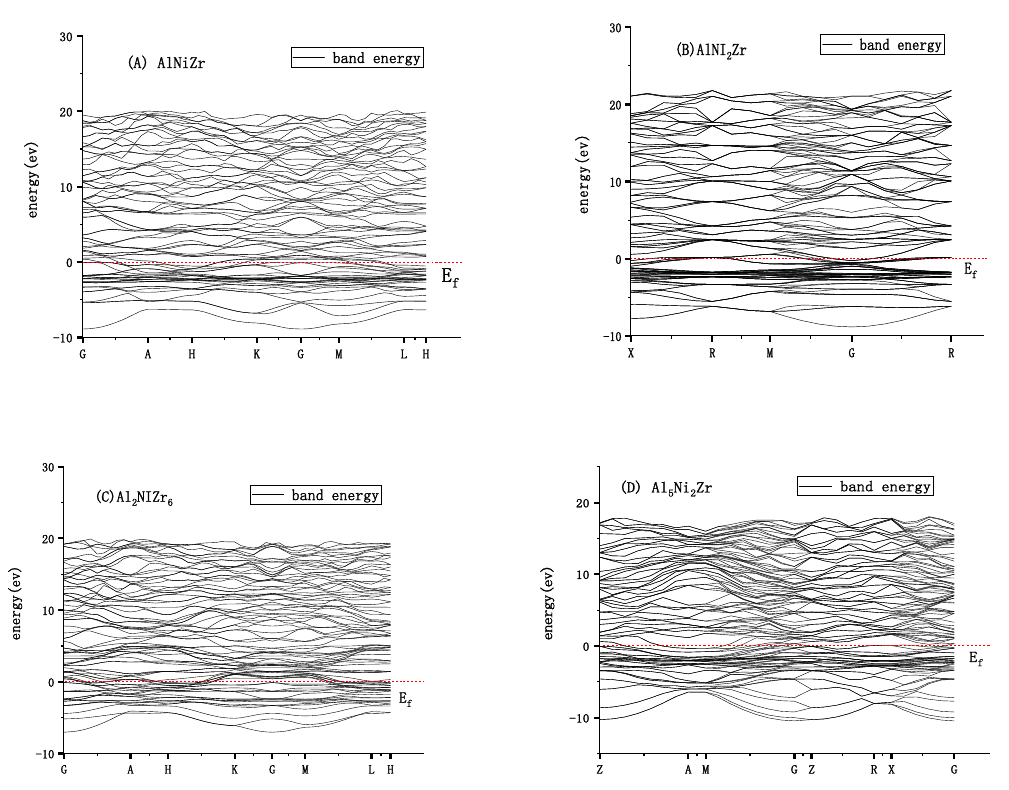
Figure 4. Band structures of Al x Ni y Zr z, ( A ) AlNiZr, ( B ) AlNi 2 Zr, ( C ) Al 2 NiZr 6 , and ( D ) Al 5 Ni 2 Zr.